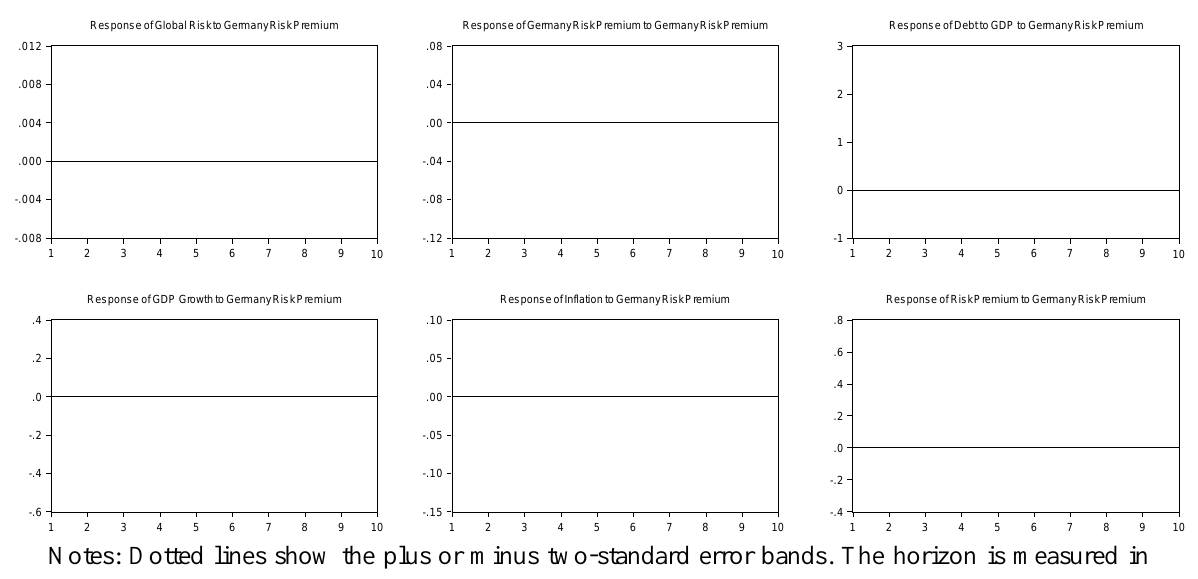
Figure 11. Response of EMU countries to a shock to Germany’s risk premium during the crisis: